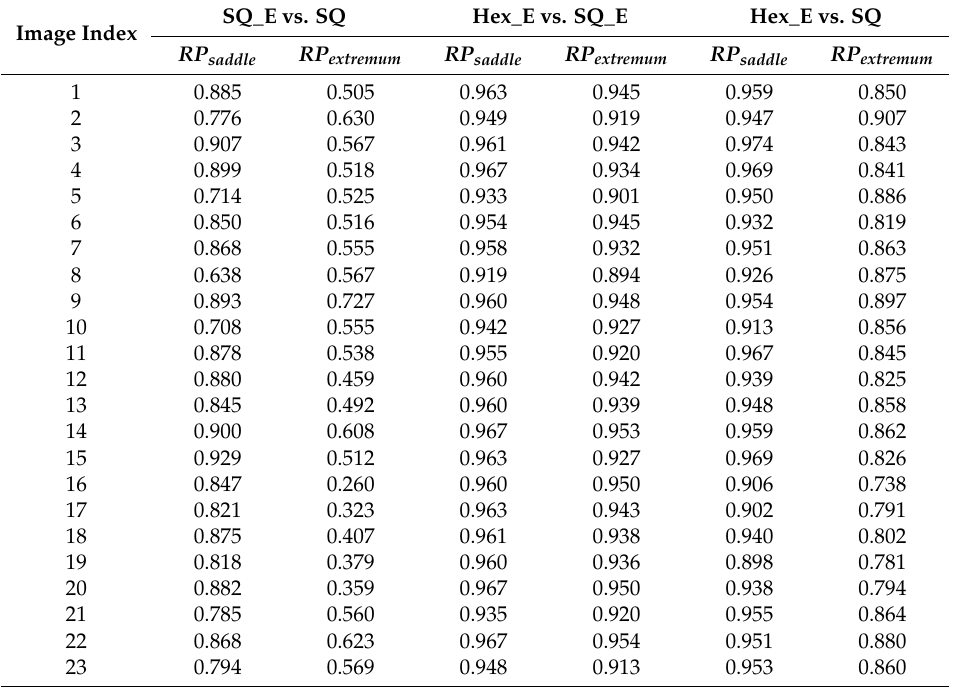
Table 6. The RP saddle and RP extremum values of three comparisons computed by the Equation (9)